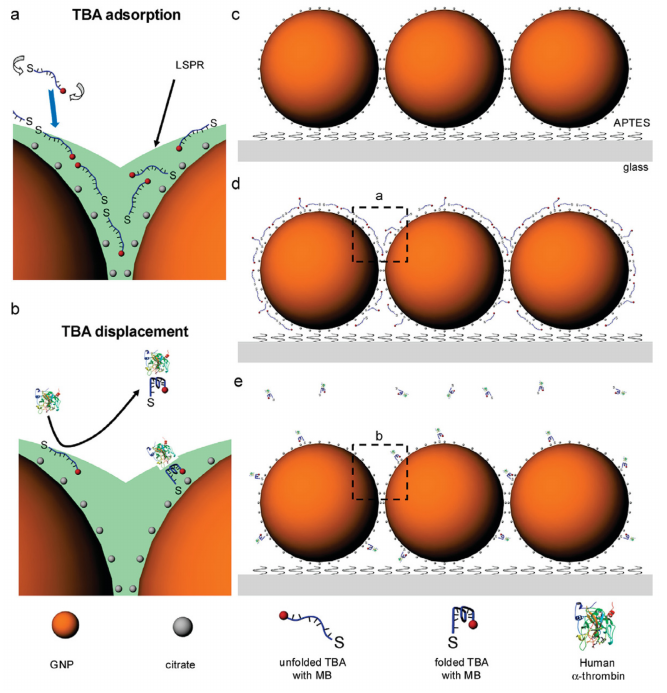
Figure 6. Schematics of the detection method of the thrombin aptamer-based SERRS biosensor. ( a ) The local structure of TBA adsorption process on the surface of gold nanoparticles. ( b ) The local structure of TBA displacement process on the surface of gold nanoparticles induced by thrombin. ( c – e ) The dynamic process of TBA adsorption and displacement induced by thrombin on the surface of gold nanoparticles. Adapted with permission from Ref. [82]. Copyright (2008), American Chemical Society.